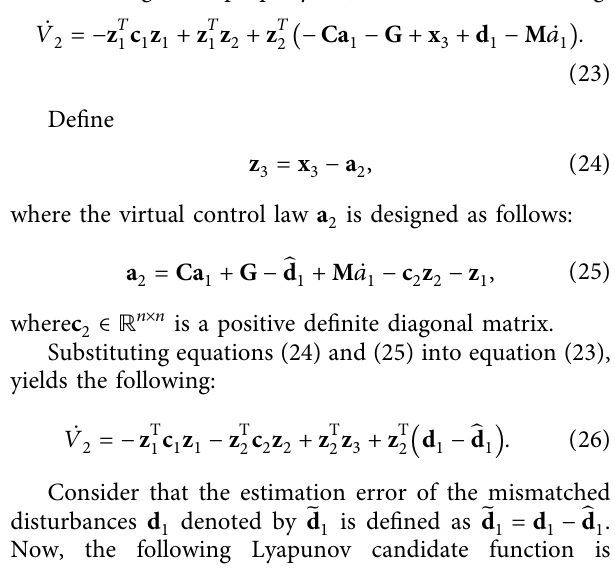
Table 1: The mechanism parameters for simulation.